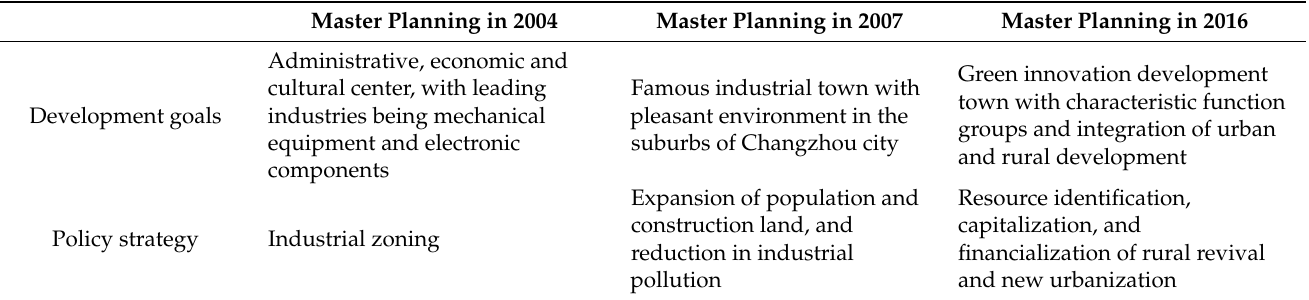
Table 1. Comparative overview of three master planning series of Lijia town.